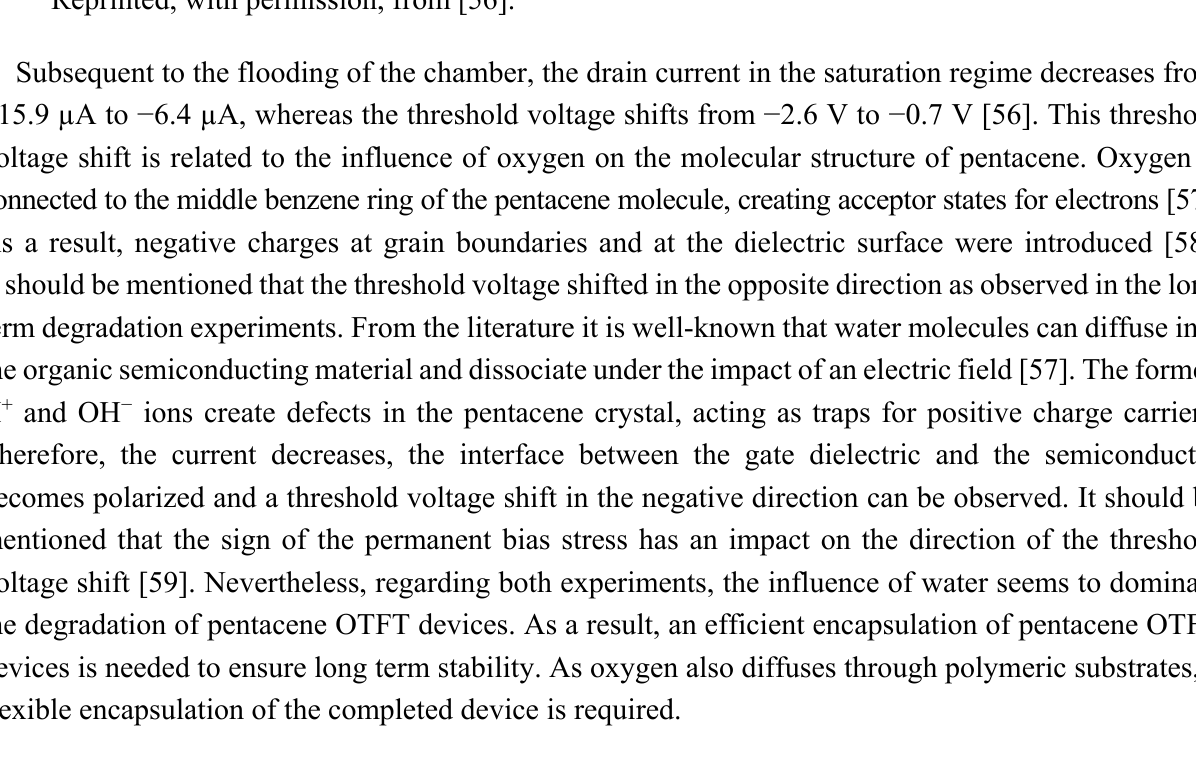
Figure 9. Transfer characteristics of an inverted coplanar pentacene OTFT using SiO 2 as gate dielectric (L = 1 µm, W = 1000 µm and t ox = 110 nm). Measurement under vacuum conditions (black curves) and after the impact of oxygen (red curves). © 2015